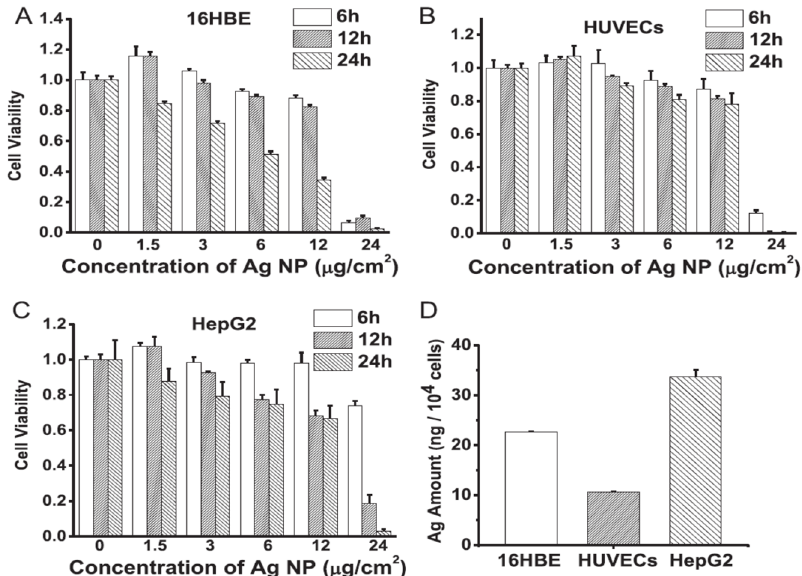
Figure 18. ( A – C ) Cell viability vs AgNP concentration for 16HBE, HUVECs and HepG2 cells determined from CCK-8 assay at different time points. ( D ) Inductively coupled plasma mass spectrometry results showing cellular uptake of AgNPs upon exposure at a dose of 2 mg/cm 2 AgNPs for 24 h. Data are expressed as means ± SD, n = 5. Reproduced from [206] with permission of Elsevier.